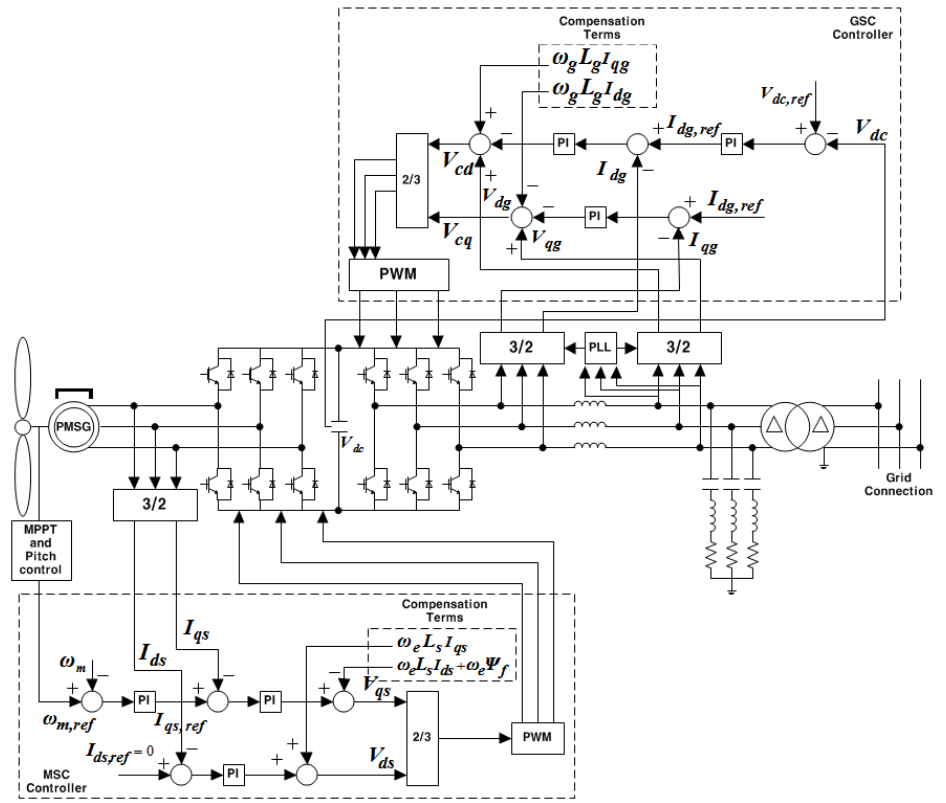
Figure 1. Schematic of the control method based on permanent magnet synchronous generators